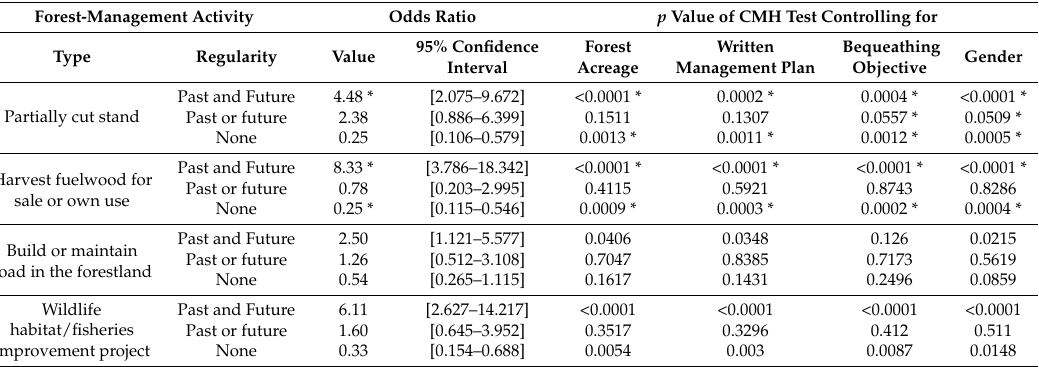
Table 3. Odds ratio and Cochran–Mantel–Haenszel results for the relationship between planning to remove invasive plants after having done so in the past five years and regularity in forest-management